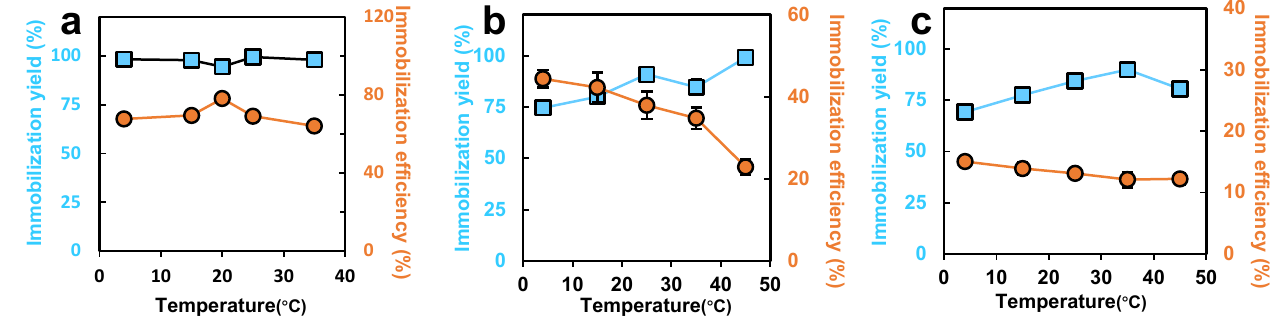
Figure 1. The effect of temperature on the immobilization of enzymes (blue rectangle: immobilization yield, yellow sphere: immobilization efficiency, ( a ) FLS, ( b ) ADH, and ( c ) NOX). The enzymes are composed of numerous amino acid residues, many of which have acidic or basic side chains. The ionization state of the side chains of enzymes varies at different pH values, and the curve of enzyme activity versus pH is usually shown as a single or double ionization curve [43]. There are two main reasons for this: altering the charged state of the substrate molecule and the enzyme molecule, thus affecting the binding of the enzyme to the substrate; and that a higher or lower pH can affect the stability of the enzyme, which could be irreversibly damaged [44]. In the immobilization step, the pH of the solution would alter the reactivity of the epoxy group on the carrier and the amino acid side chain groups (amino and carboxyl) on the protein [42]. Consequently, we investigated the effect of pH on the immobilization process (Figure 2). The immobilization yields of the three enzymes fluctuated slightly at pH 6–11, and the immobilization yields 75~95% could be obtained. This was mainly attributed to the high reactivity of the epoxide group with the protein side chain moiety [42]. In contrast, the immobilization efficiencies of the three enzymes differed significantly (71% for FLS at pH 7, 41% for ADH at pH 8, and 22% for NOX at pH 9). Notably, ADH lost its catalytic activity at pH 10–11, which may be related to the stability of the enzyme itself. Finally, we chose the pH that obtained the maximum immobilization efficiency as one of the conditions for immobilization.